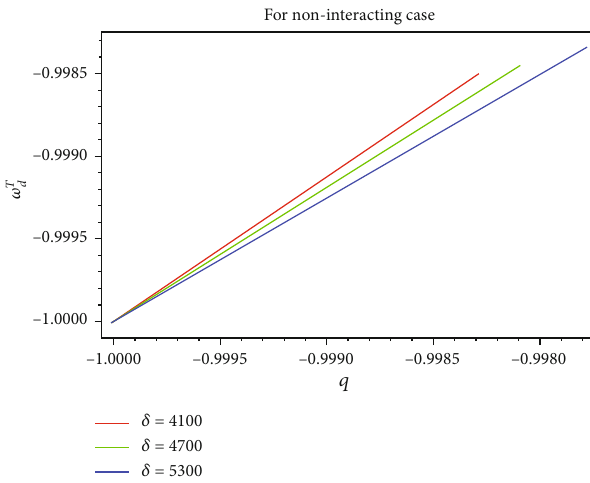
Figure 14: Behavior of coincidence parameter ~ r = Ω